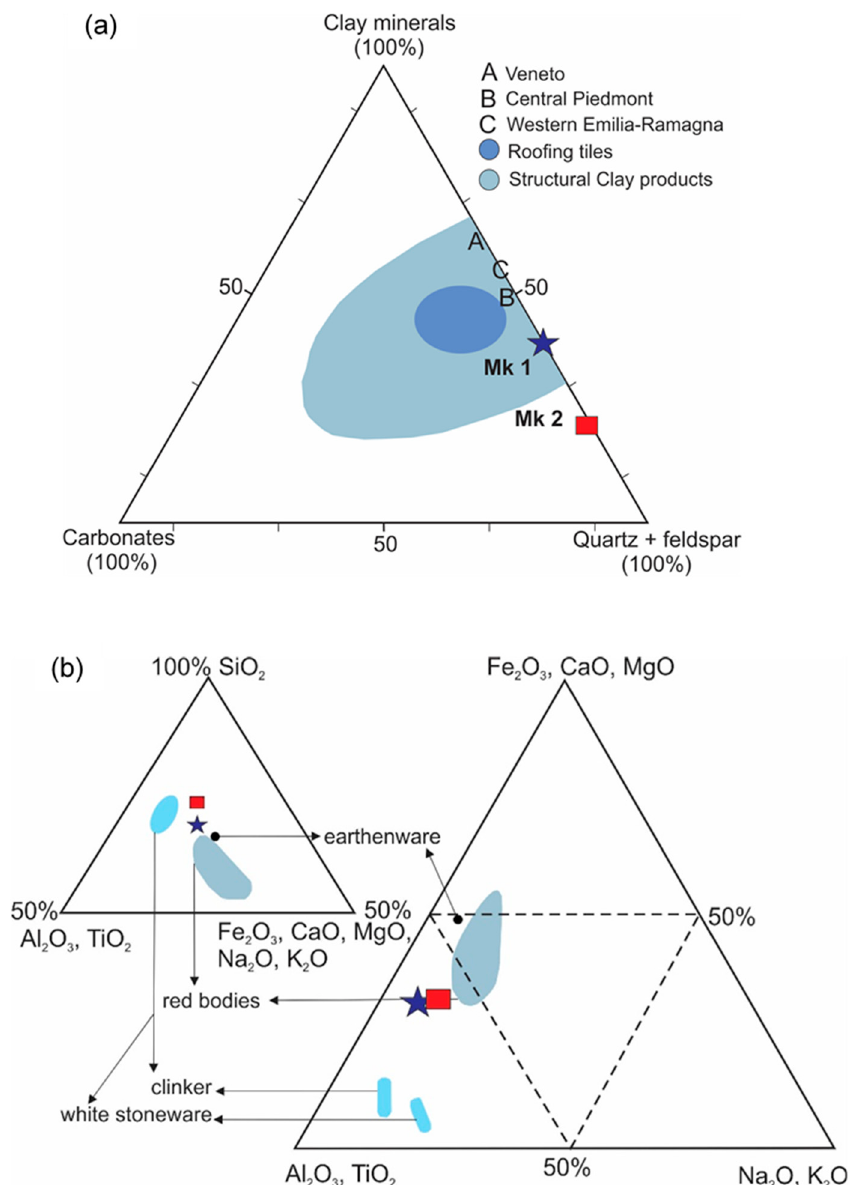
Figure 5. Mineralogical and geochemical classification of raw clay materials: ( a ) Clay, carbonate, quartz, and feldspar ternary diagram [38]; ( b ) major oxide content [40].